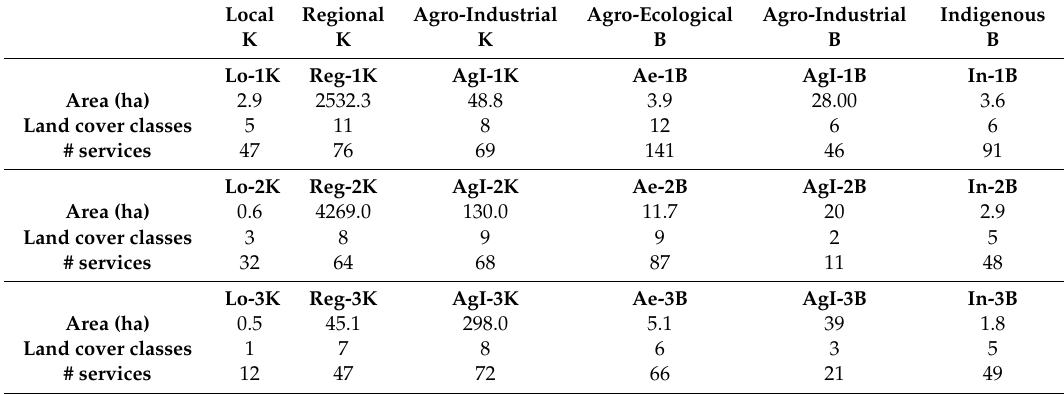
Table 3. Area, number of land cover classes and agroecosystem services provided and CPR compliance of the 18 agroecosystems data for Bolivia